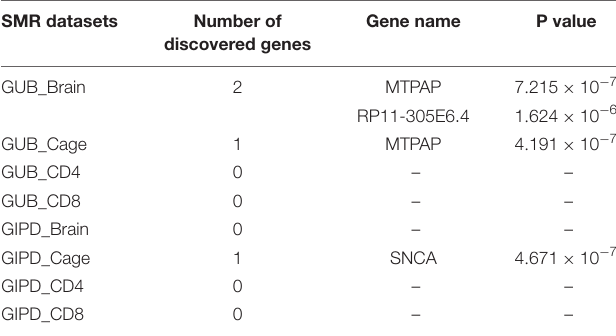
TABLE 3 | Discovery of PD causative gene by the Summary data-based Mendelian Randomization (SMR) analysis for these eight datasets. SMR